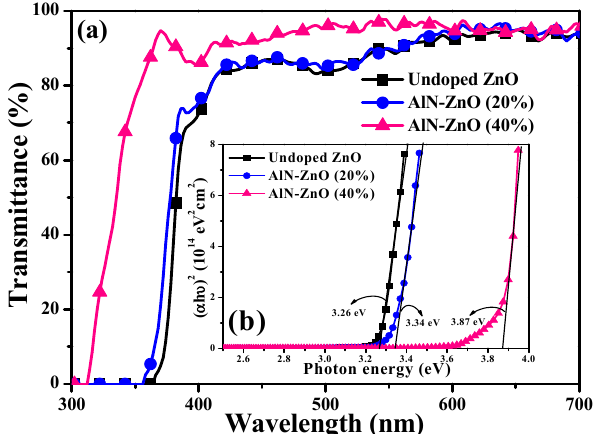
Figure 2. ( a ) Optical transmittance of the undoped ZnO film and the cosputtered AlN-ZnO films at a theoretical Al atomic ratio of 20% and 40%, respectively, annealed at 700 °C for 30 min under vacuum ambient (( b ) corresponding optical energy bandgap evaluated from the relationship between ( α h ν ) 2 and photon energy ( E g )).